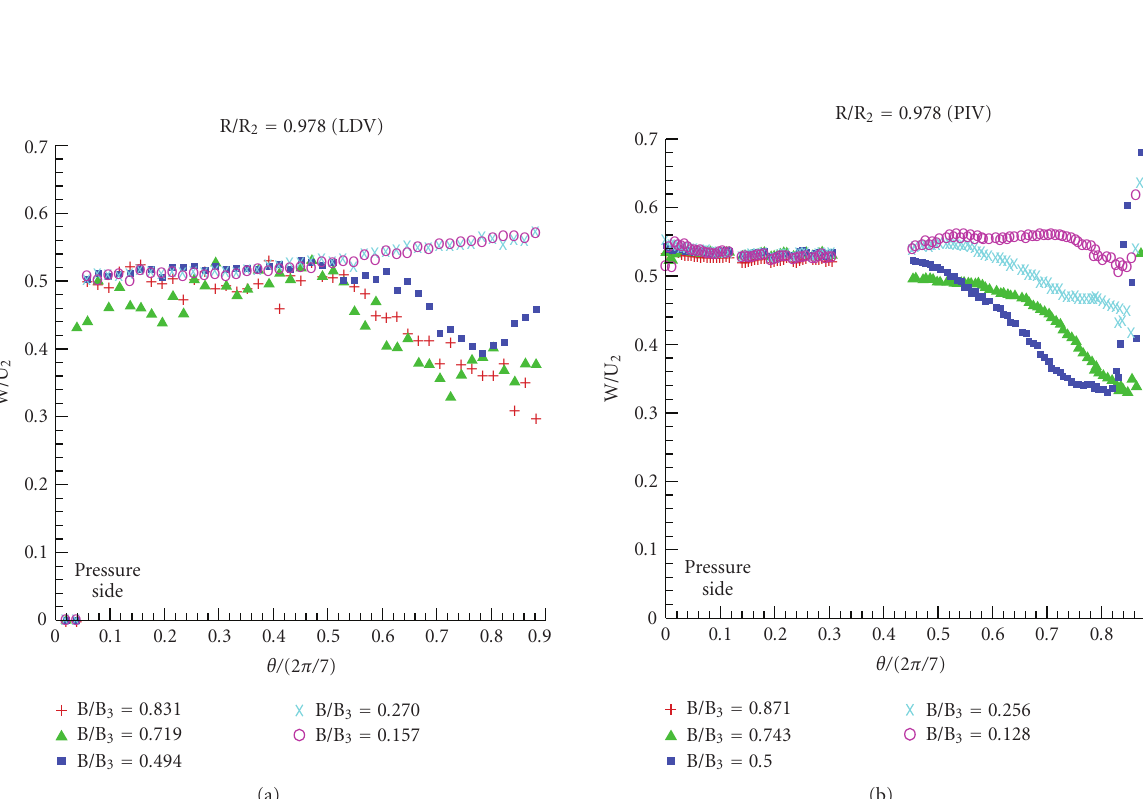
Figure 3: Evolutions of W/U 2 in the blade-to-blade direction at a constant radius r ∗ = 0 . 818.